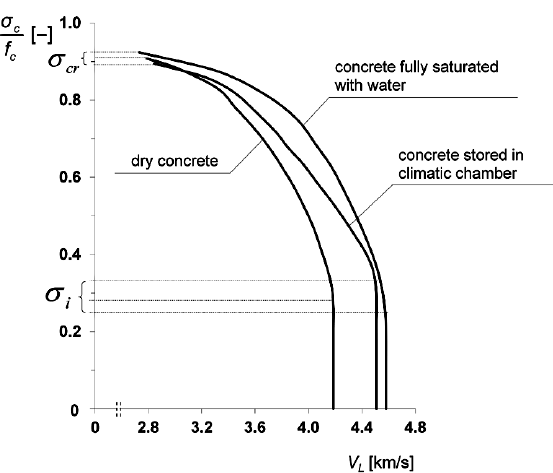
Fig. 7. Change in velocity of longitudinal ultrasonic waves in self-compacting concretes under compression versus increment in relative value of stress